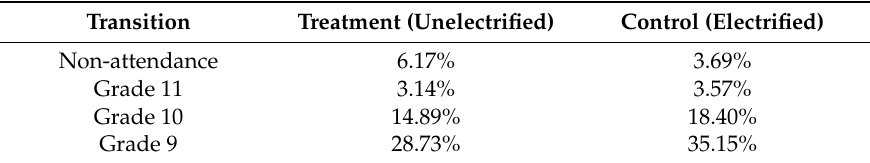
Table 8. Long-term impact of access to